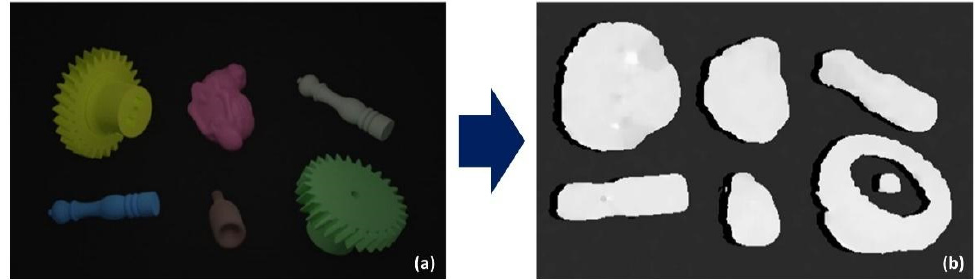
Figure 7. ( a ) Example image; ( b ) the disparity map extracted from an example image. In order to estimate the translation of the objects from the camera, the centroid in world coordinates is calculated and taken as the coordinates of the center of the object.